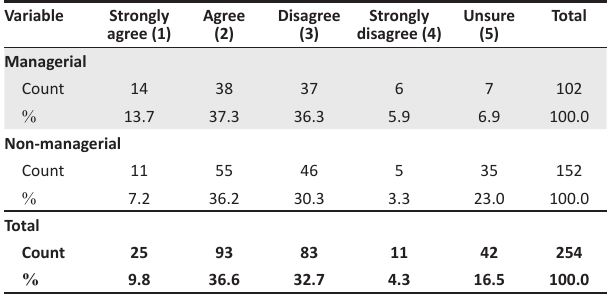
TABLE 6: Participants’ response on adoption of cost-saving